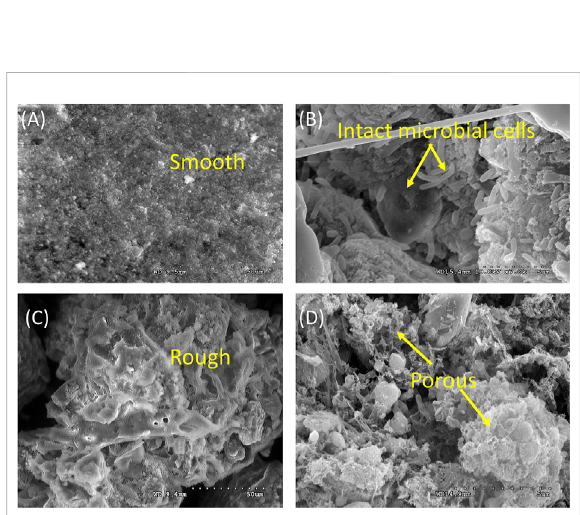
FIGURE 6 (A,B) Rw WAS morphology and (C,D) after 2 h